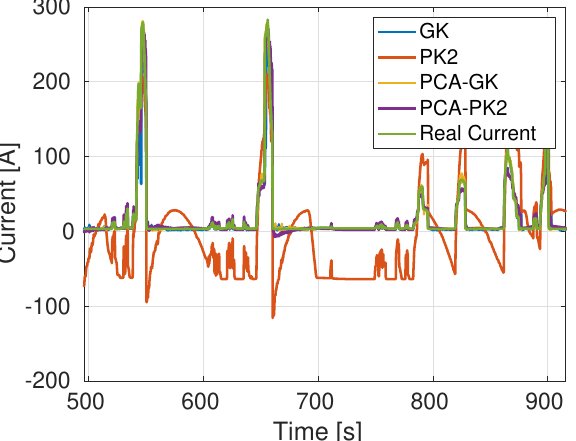
Figure 3. A sample of predicted current on the same route used for training—in this case Route 1. The PCA + PK6 model is not